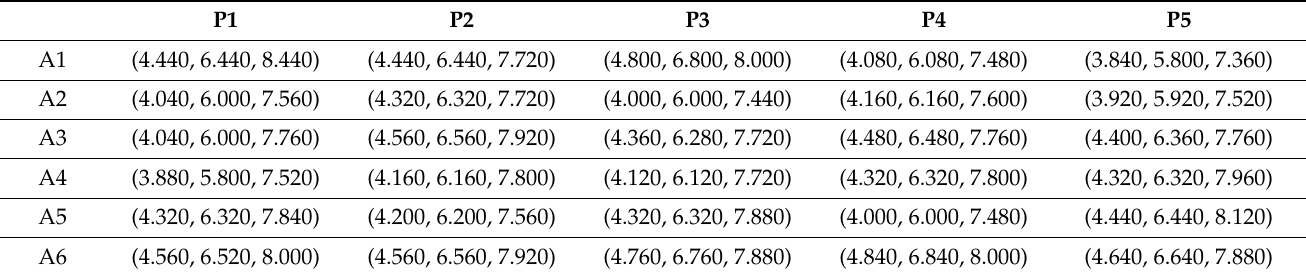
Table 4. Decision matrix.